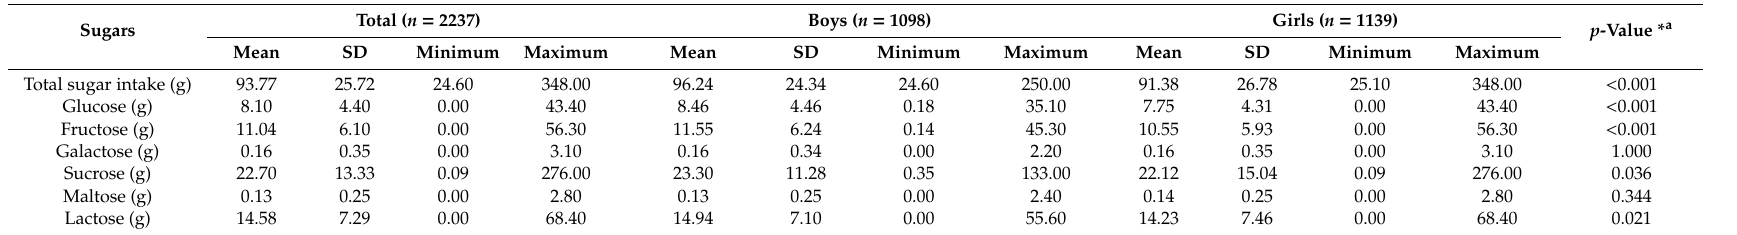
Table 2. Breakdown of total sugar intake consumed by 6–8 years old children ( n = 2237) in Valencia, Spain, 2018. Sugars Total sugar intake (g)